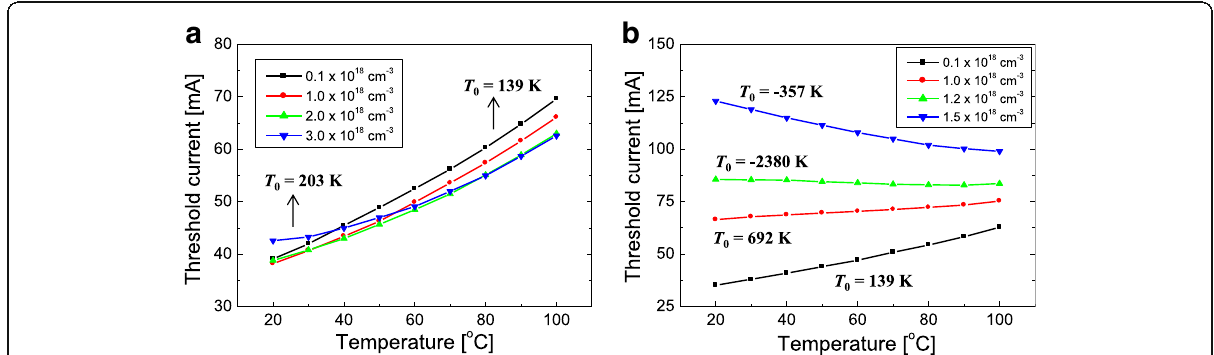
Fig. 7 Threshold current ( I th ) as a function of temperature for barrier doping concentrations of 0.1, 1, 2, and 3 × 10 18 cm − 3 when the barrier thicknesses are a 6 and b 15 nm. The T 0 value for each doping concentration is shown. Here, the barrier doping concentration is fixed at 1 × 10 18 cm −